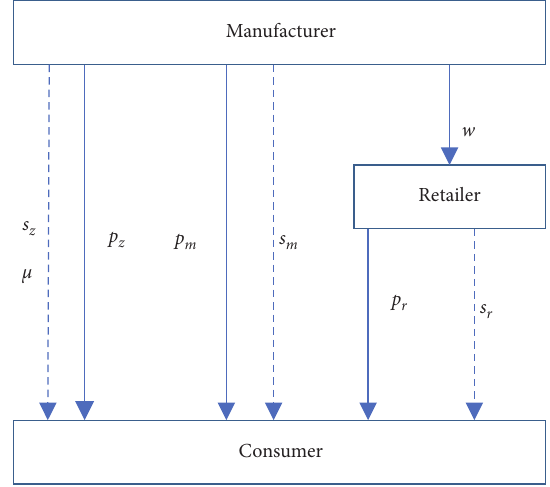
Figure 1: A dual-channel SC